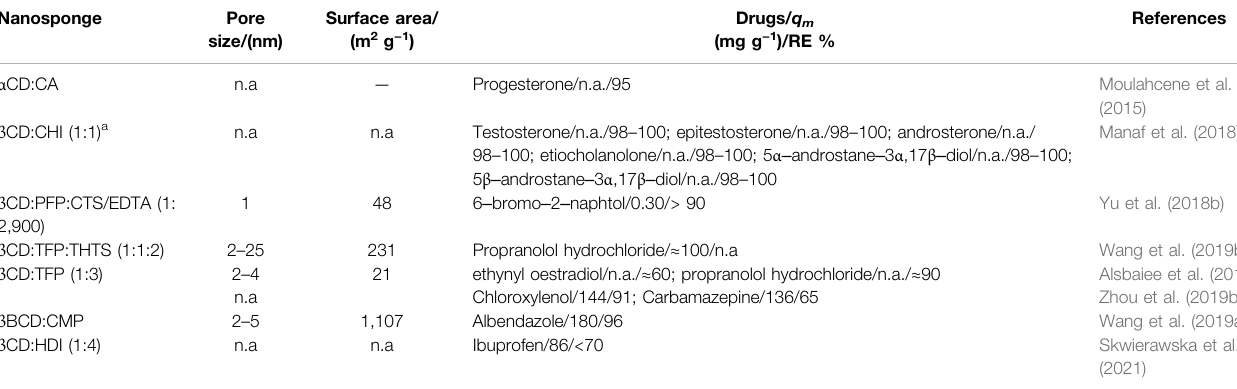
TABLE 7 | Nanosponges developed for drug removal (2015 –